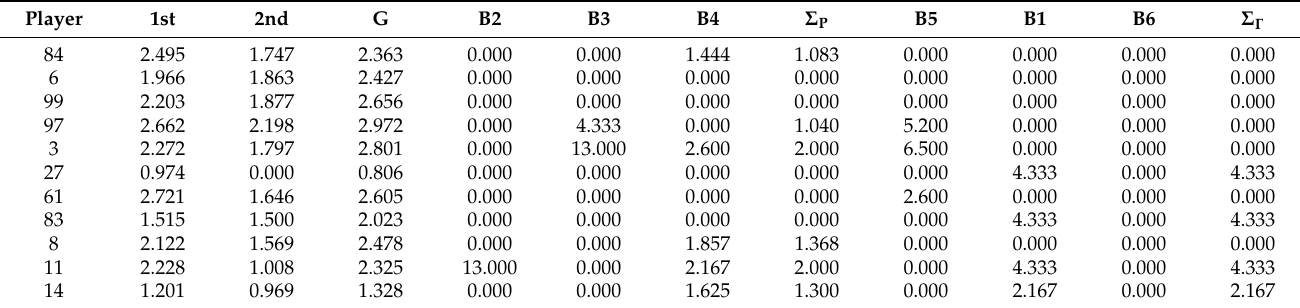
Table A3. Team A’s Closeness Centrality Matrix of values.